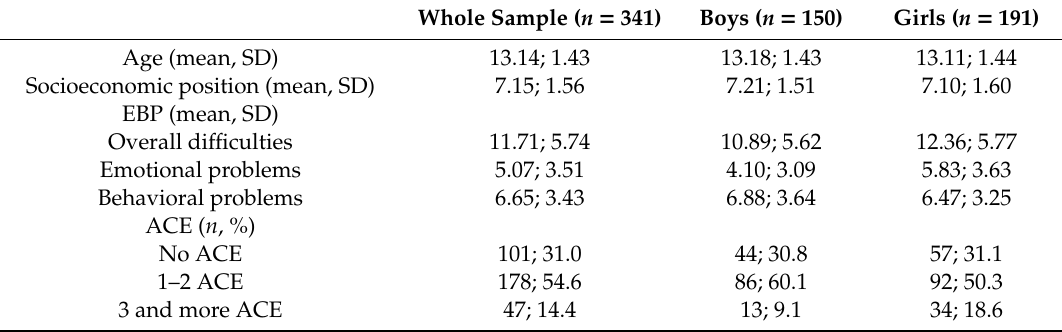
Table 1. Descriptive statistics for age, socioeconomic position, emotional and behavioral problems, and adverse childhood experiences, overall and by gender (Slovakia 2017, 10–16 years old, n =